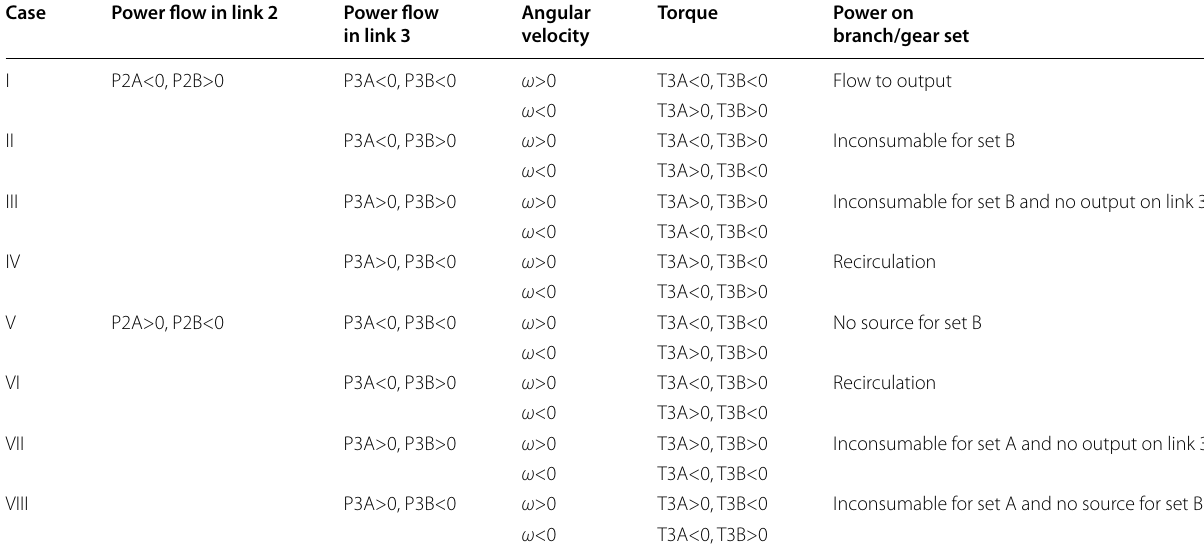
Table 2 Variation for directions of torque and power within power branch 3A‑3B Case